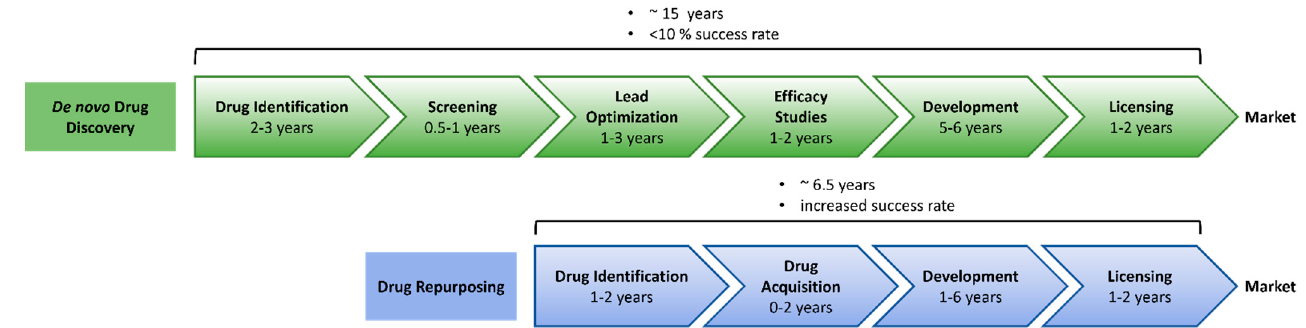
Figure 3. Timeline of conventional drug discovery versus drug repurposing. Figure adapted from [76] and generated with Powerpoint.